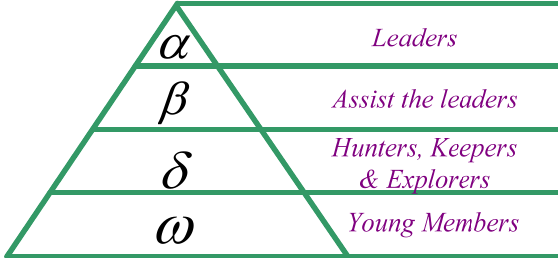
Figure 15. Grey wolves hierarchy sequence.